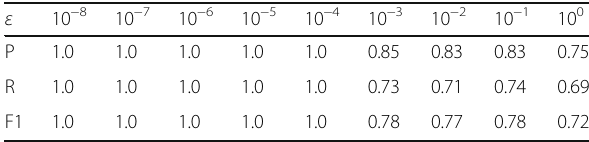
Table 1 The impact of the threshold ε of classification decision function in the VCA method on the classification performance (without